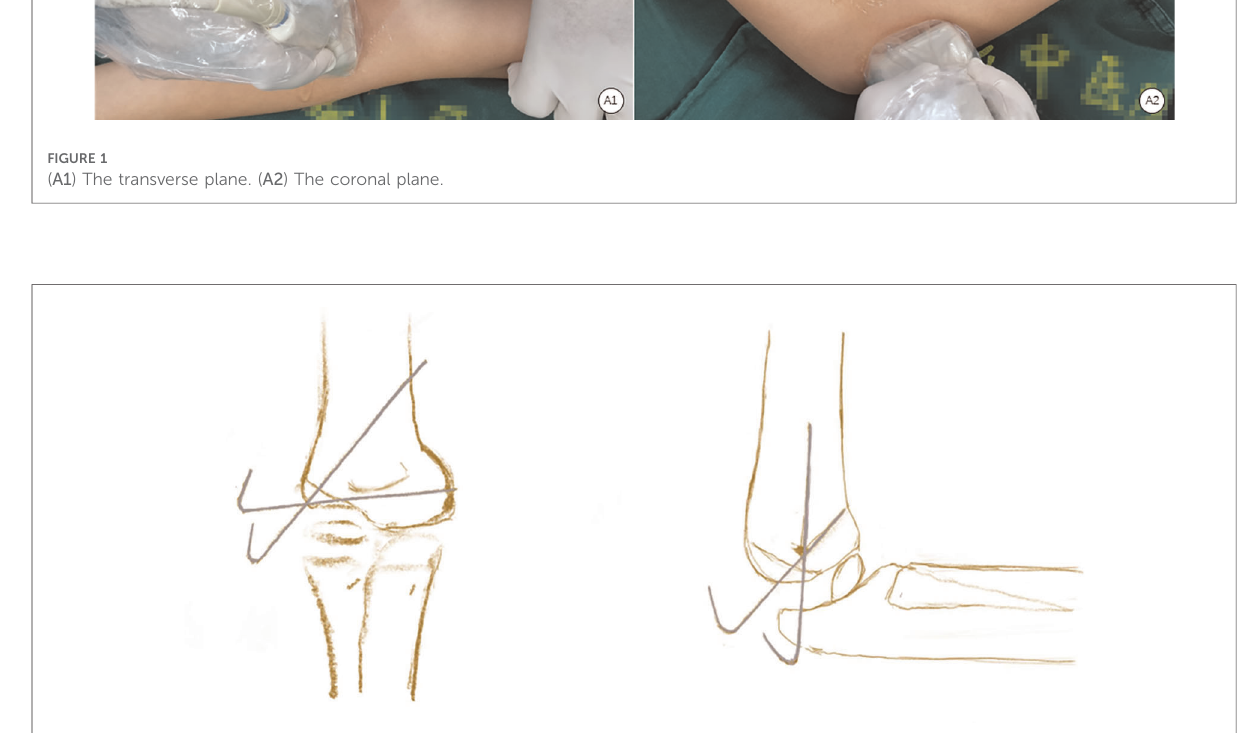
FIGURE 2 Intraoperative K-wire insertion angle.